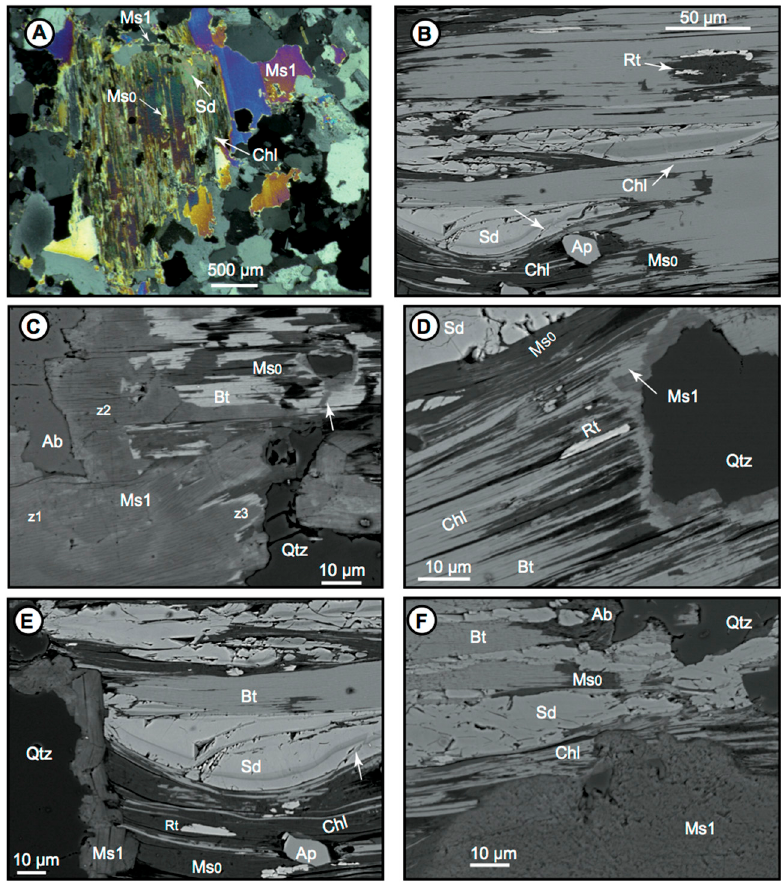
Figure 12. Alteration assemblages in G1 biotite (sample PAN-16-5). Ap apatite, Bt Biotite (protolithionite), Chl chlorite, Ms0-Ms1 muscovite, Rt rutile, Sd siderite. ( A ) Microphotograph in cross-polarized light, ( B – F ) SEM-BSE images. ( A ) Overview of altered biotite. Note the muscovite microcrack (Ms1) issued from a large Ms1 flake. ( B ) Alteration assemblage. Patchy muscovite (Ms0) is the earlier phase, overprinted by siderite and chlorite. Siderite is overprinted by chlorite (arrow). Note the intimate association between rutile and muscovite Ms0. ( C ) Relationships between a flake of muscovite (Ms1) and the altered biotite (Bt-Ms0 assemblage). Ms1 dilacerates the altered biotite; note in particular the Ms1 microcrack (arrow). Z1-3: zoning of the Ms1 (see Figure 10). ( D ) Overprinting of the Ms0-Chl assemblage by Ms1 developed at a quartz interface. ( E ) Overprinting of the Ms0-Chl-Sd alteration assemblage by an Ms1 microcrack at a quartz-biotite interface. Chlorite overprints siderite (arrow). ( F ) Obliteration of an Ms0-Chl alteration assemblage by an Ms1